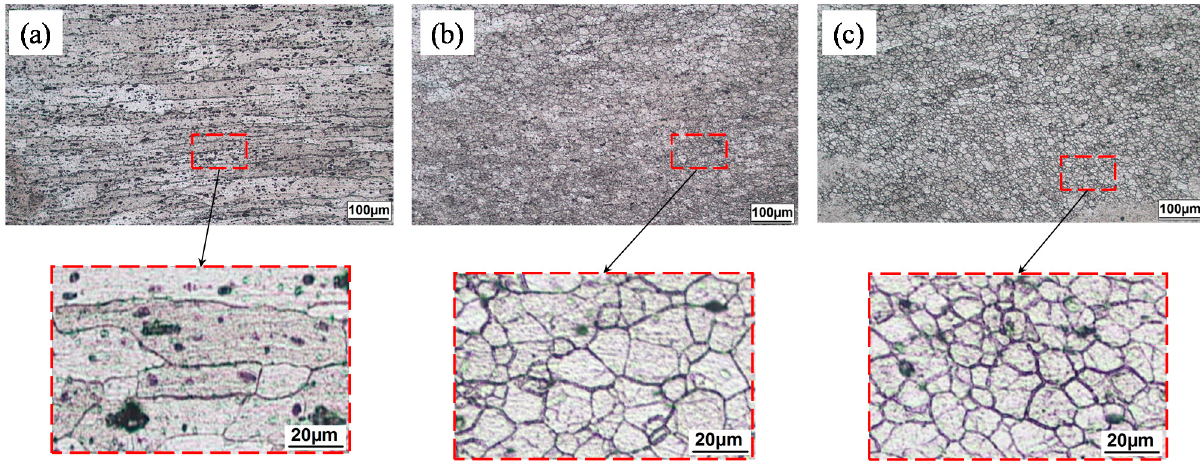
Figure 7. Microstructures within the HAZ of welded joints for: ( a ) the as-welded sample; ( b ) the in situ rolled sample with 6 mm ball diameter; ( c ) the in situ rolled sample with 8 mm ball diameter.